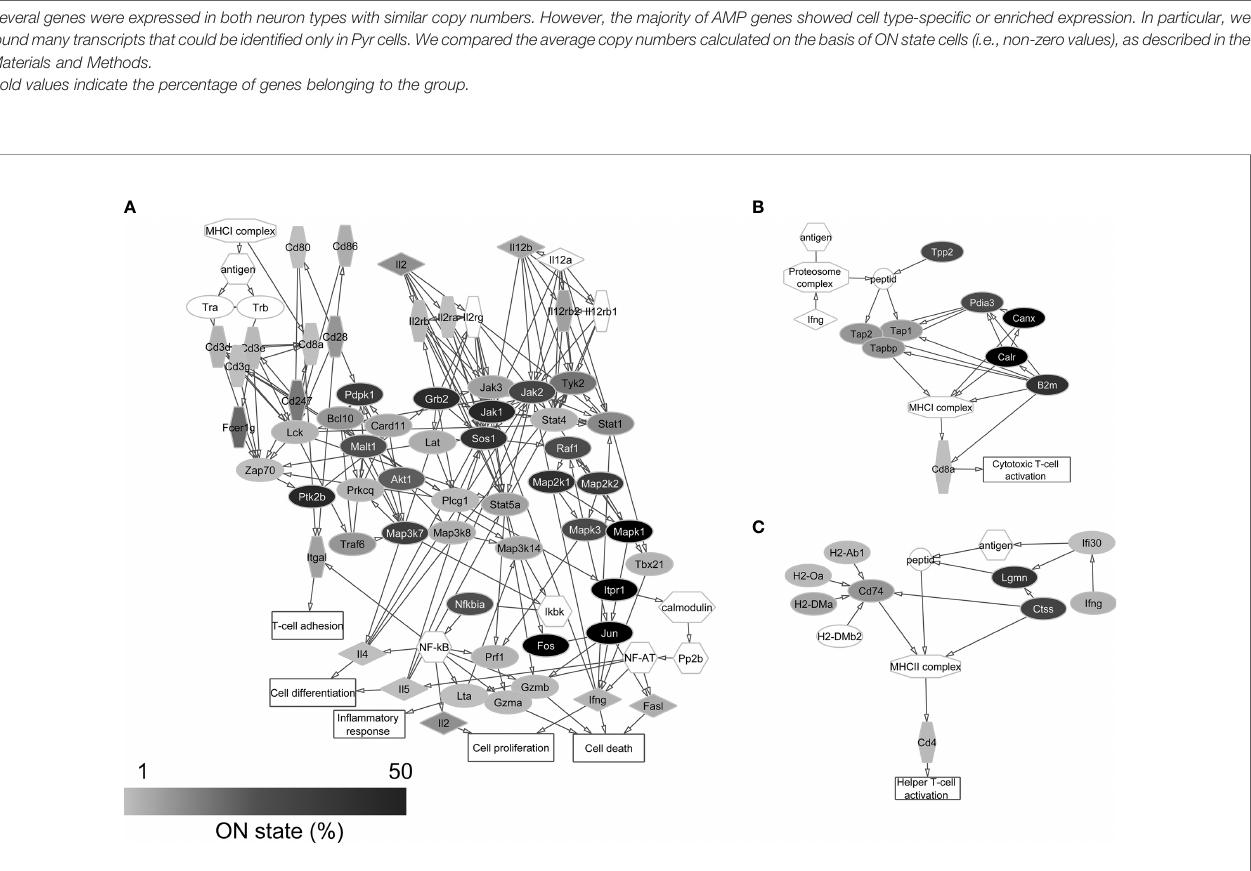
Table 2 ). The average ON state frequency of genes encoding proteins of immune cell processes is somewhat higher in